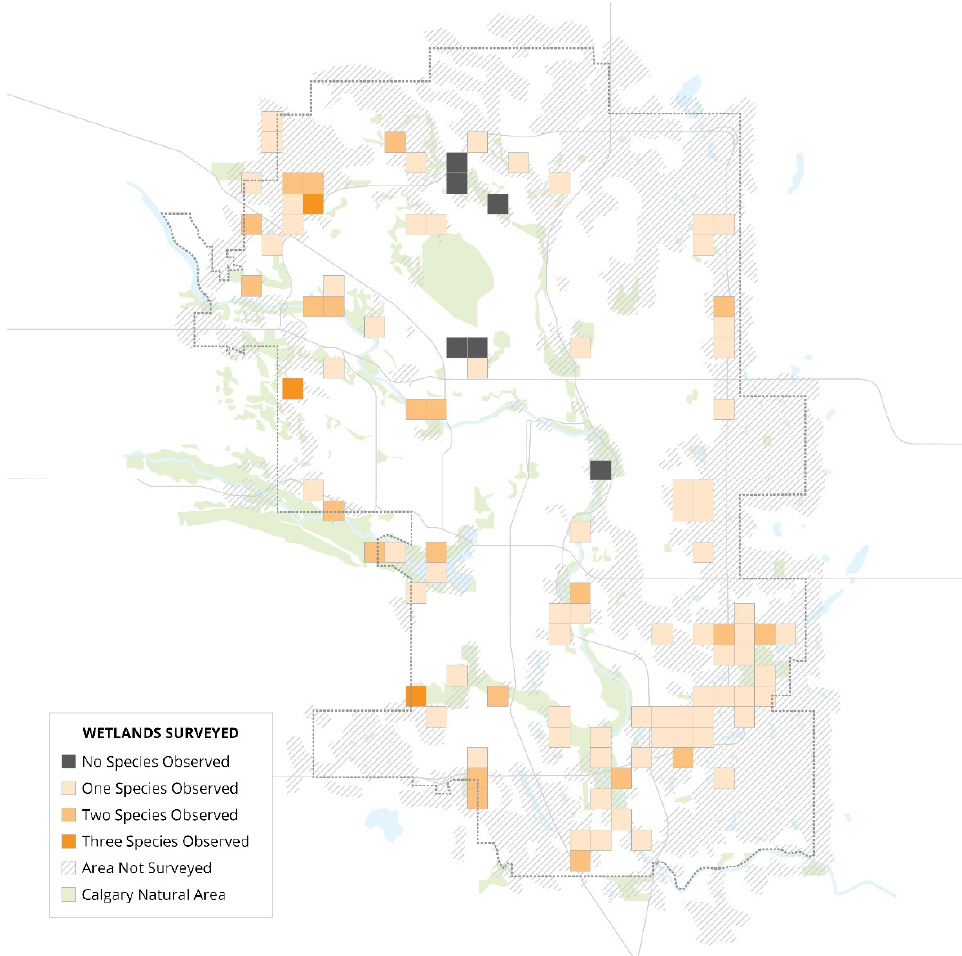
Figure 2. Map depicting the number of amphibian species observed at Calgary wetlands from 2017 to 2019. Species were not necessarily observed in the same year. Map includes incidental observations submitted in addition to observations at survey